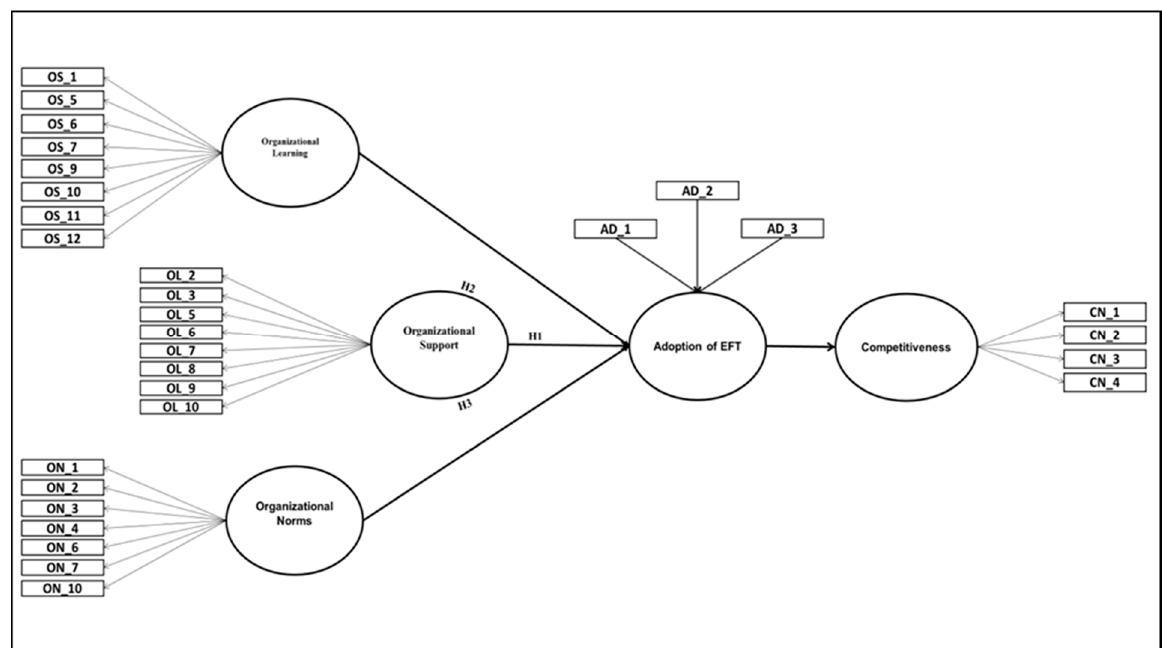
Figure 1. Conceptual model.